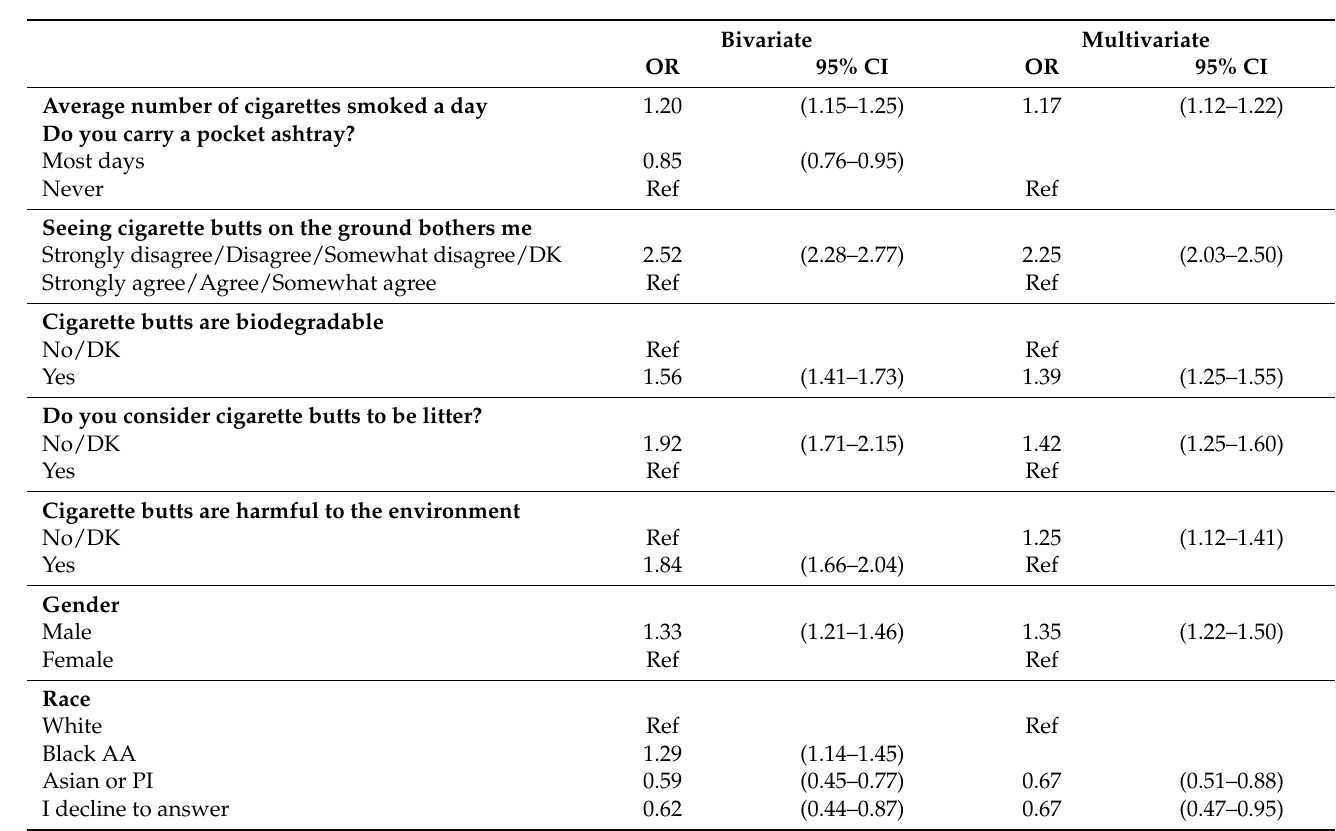
Table 5. Statistically significant predictors of littering † the last cigarette smoked among